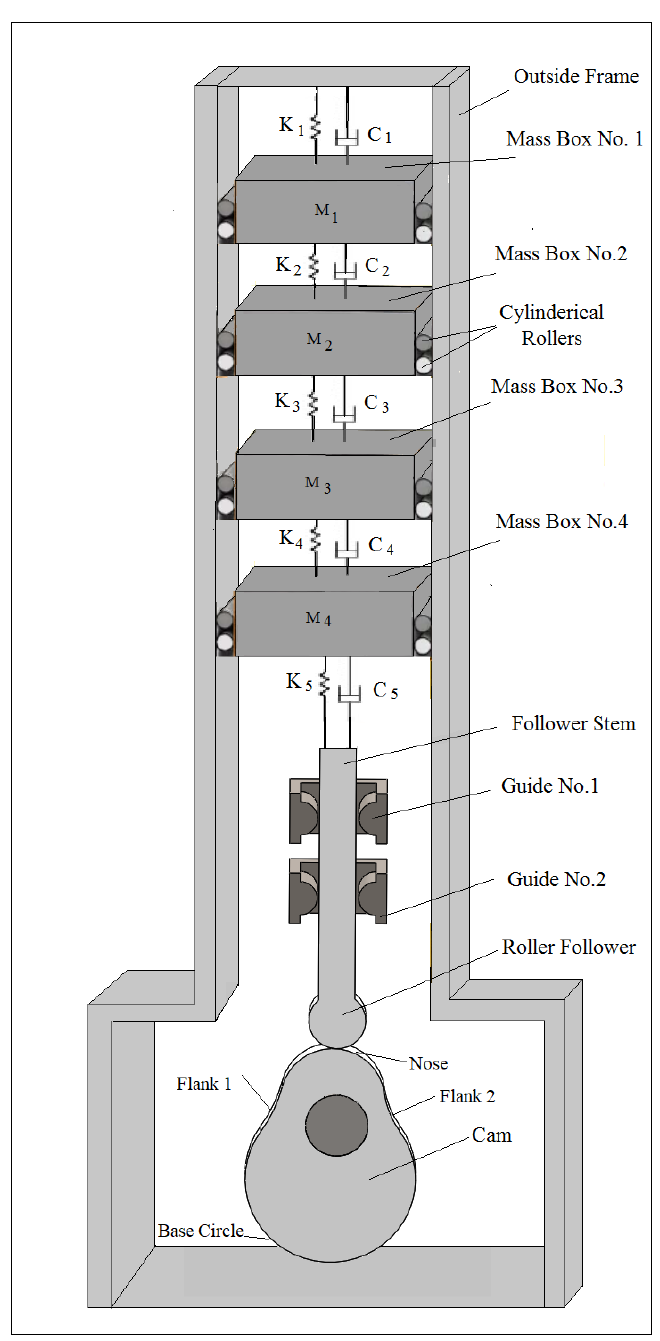
Figure 2. Cam follower system with multi degrees of freedom.